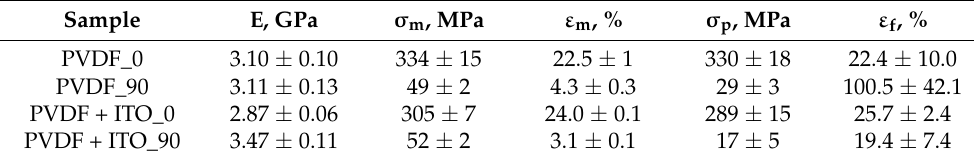
Table 3. Elastic strength properties of PVDF fi lm.